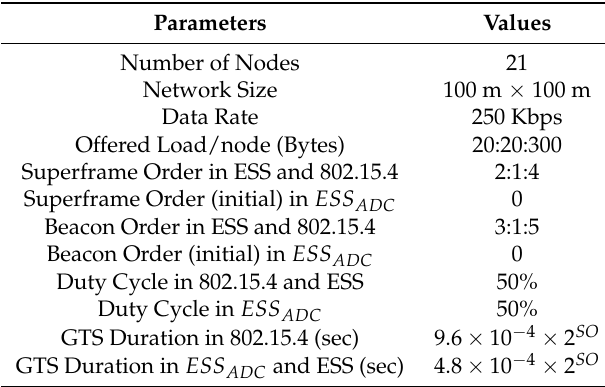
Table 2. Simulation